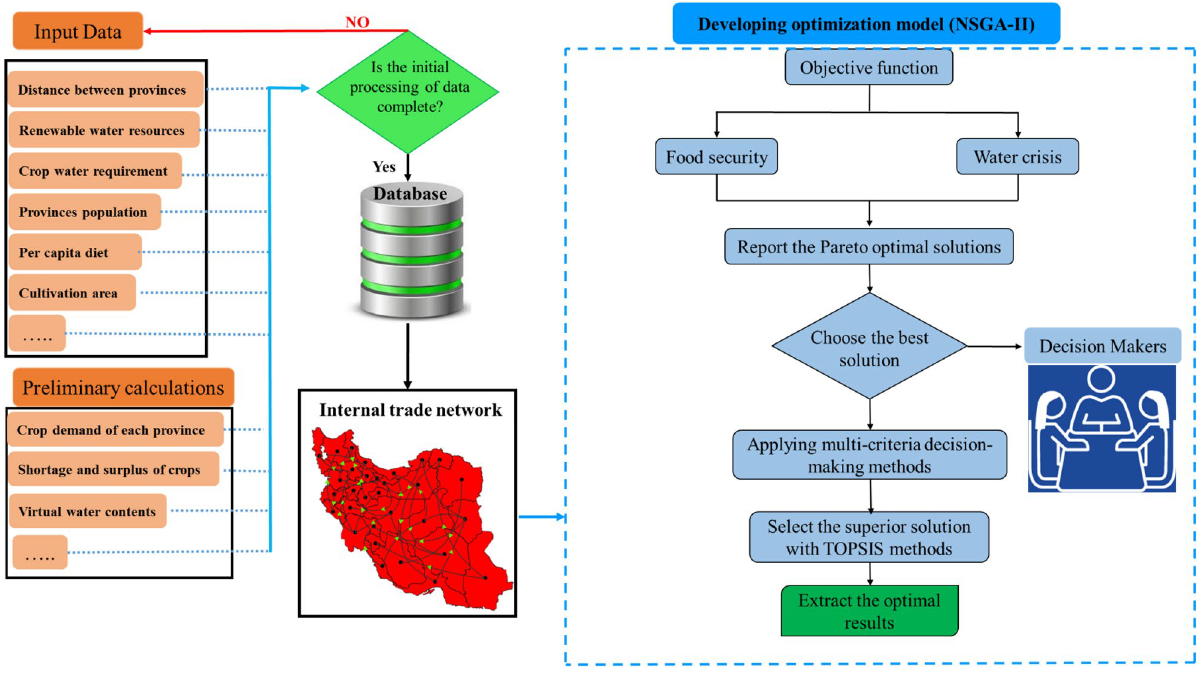
Figure 1. Flowchart of the